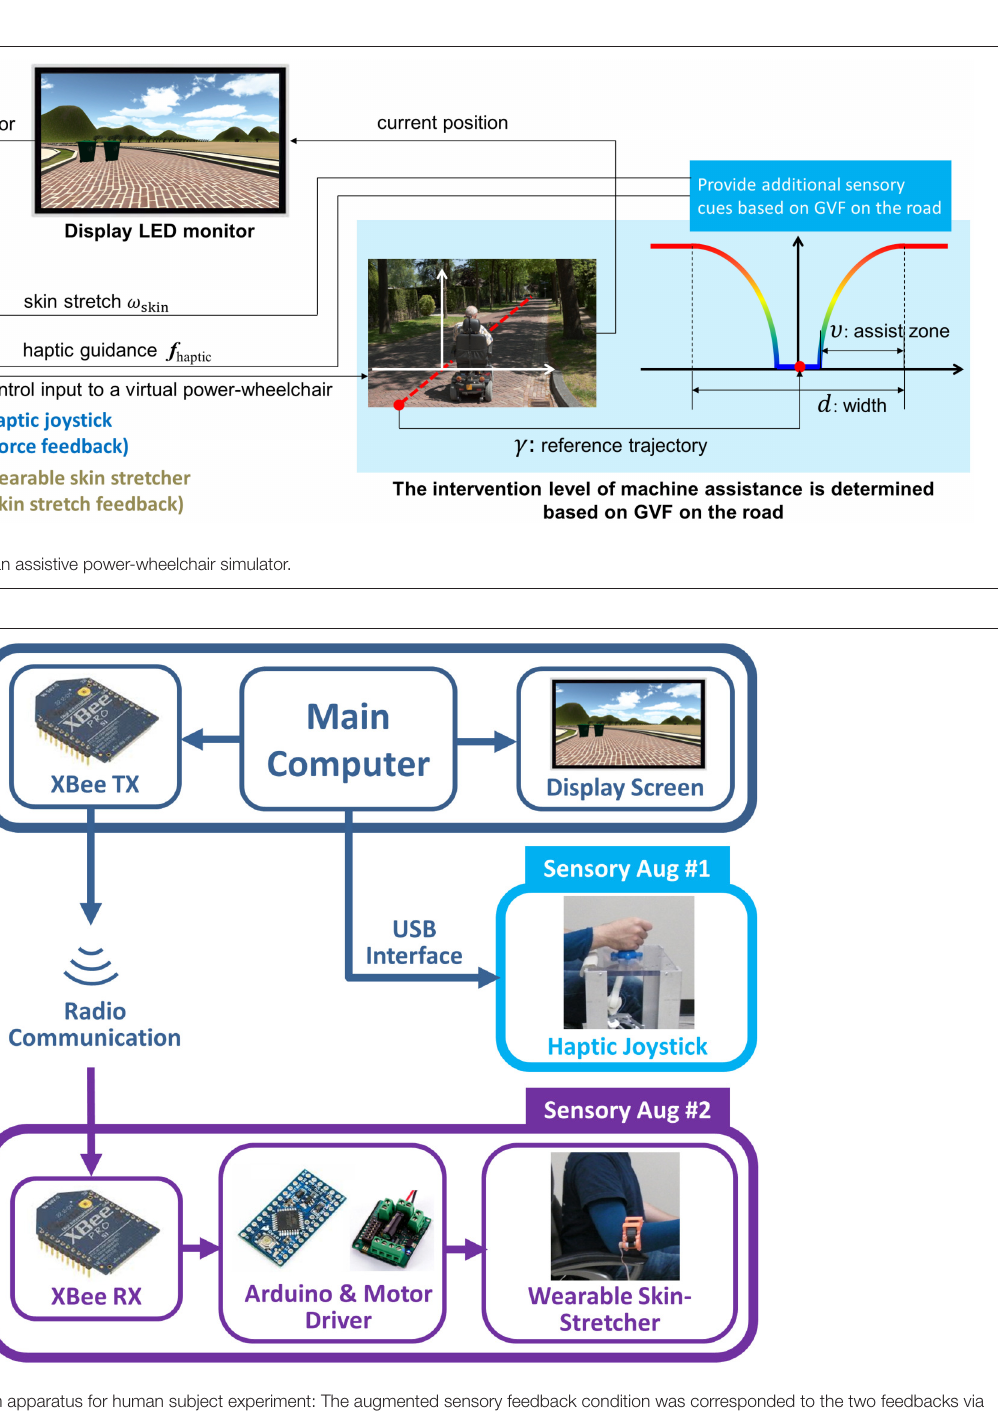
Frontiers in Neurorobotics |